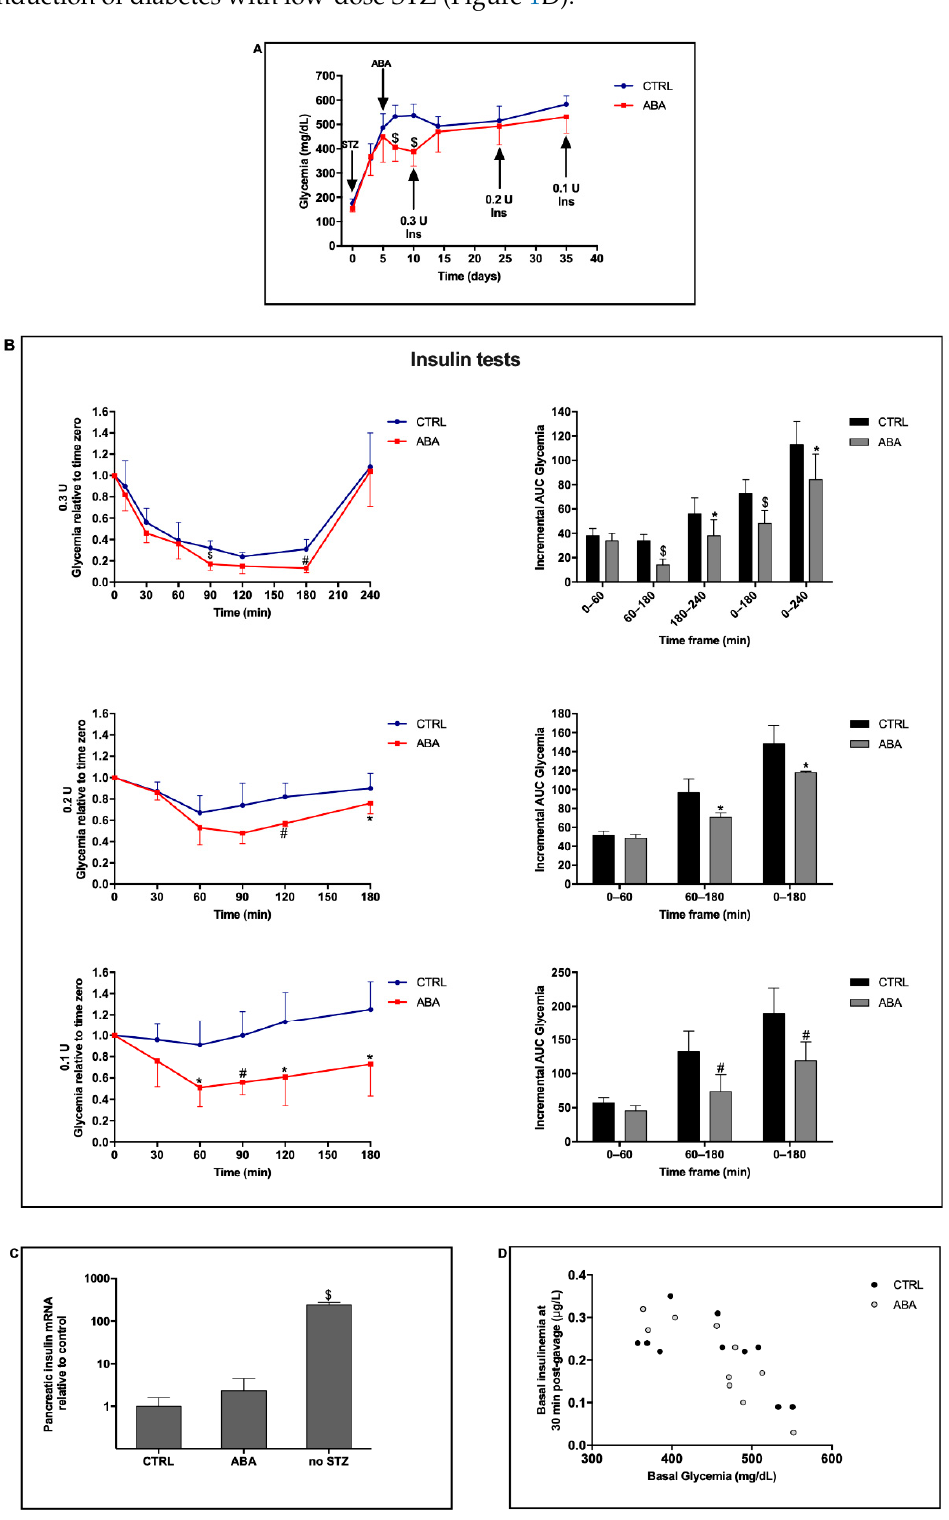
Figure 3. Chronic ABA treatment improves the efficacy of low-dose insulin in hyperglycemic T1D mice. LANCL2+/+ (wild-type) mice (10/group) received a single high-dose STZ injection (200 mg/Kg